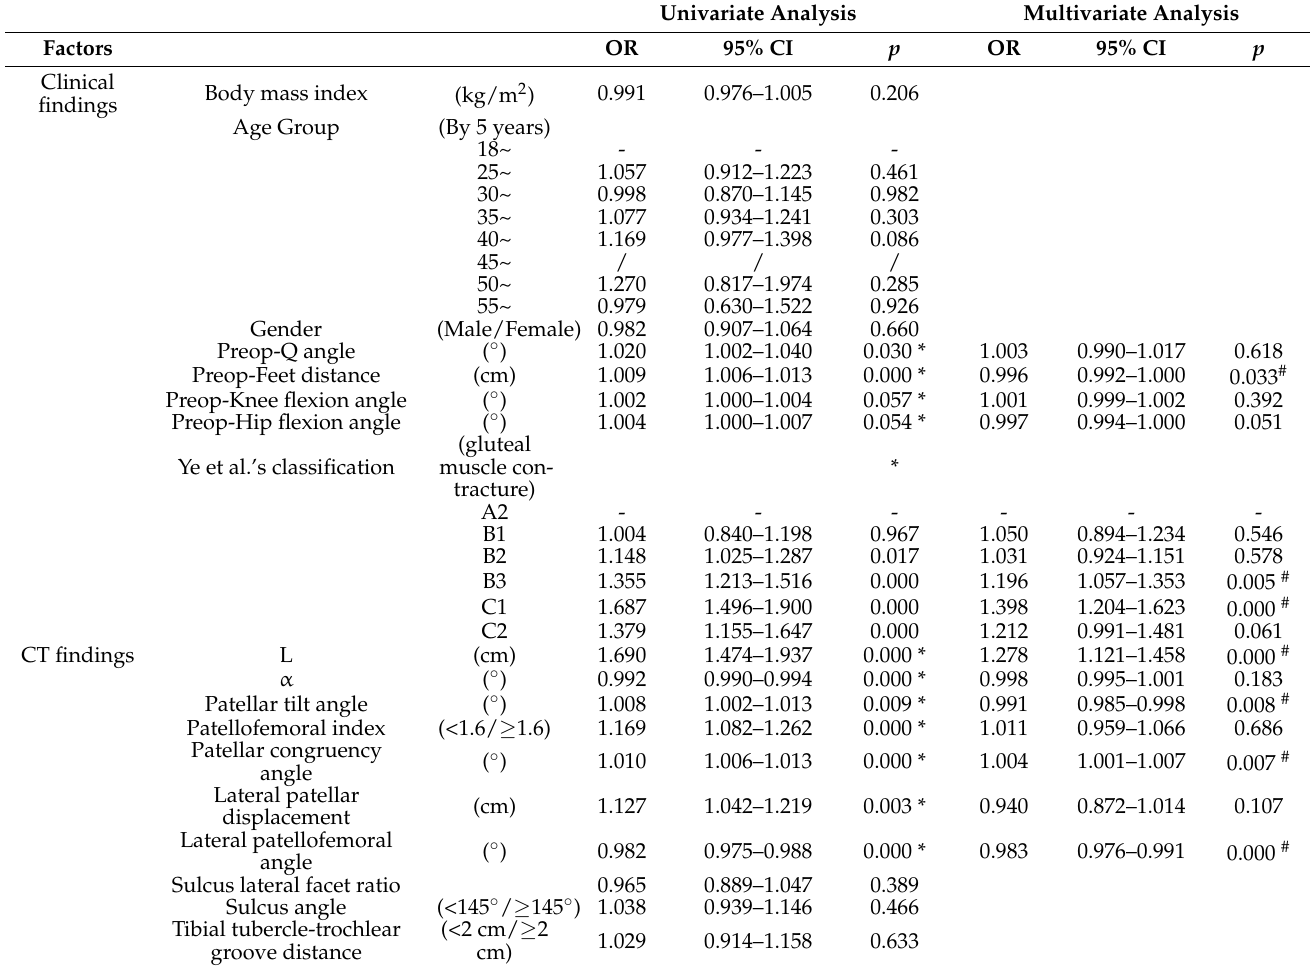
Table 4. Factors associated with the difference between P-FT area and FT-P area in the generalized linear mixed